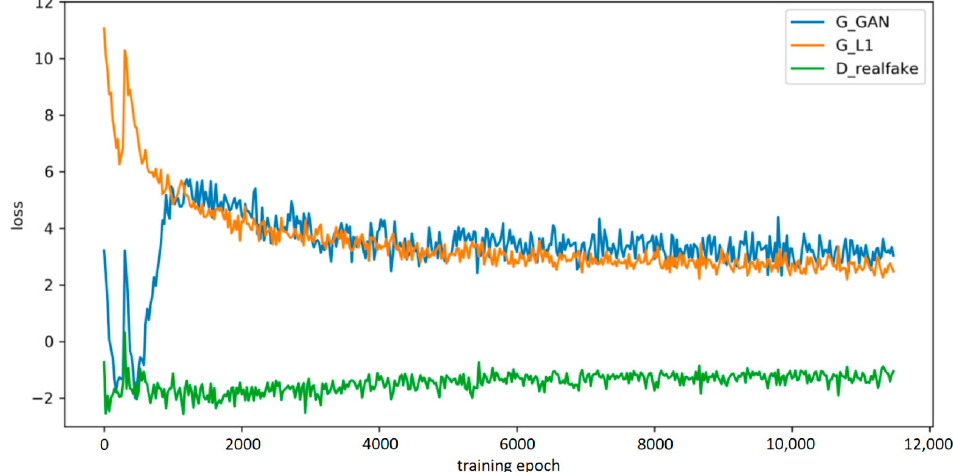
Figure 8. The loss curves. As can be seen in this figure, the losses converged to a steady state progressively. L GAN and L 1 decreased while L D increased in the long term. After about 4000 epochs, the training process became stable.